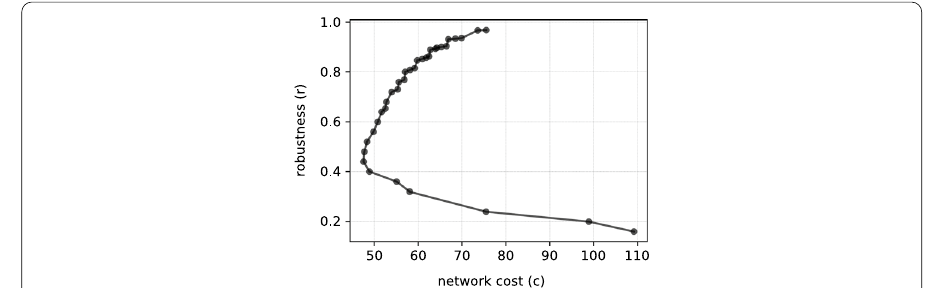
Fig. 2 An example of a typical Pareto front of an ( c , r )